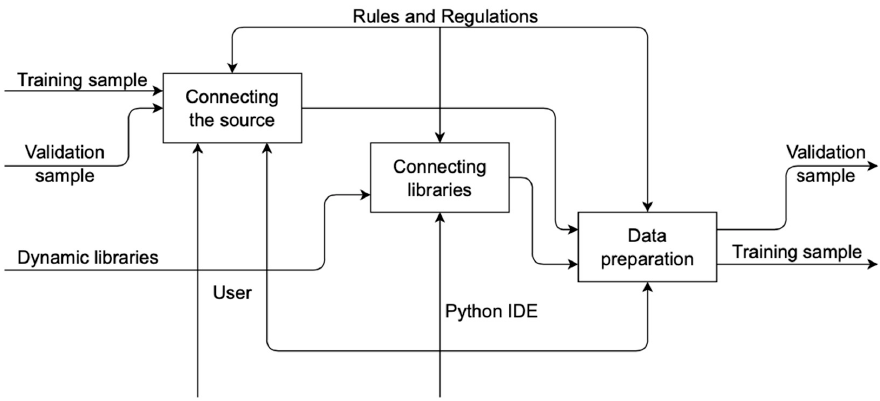
Figure 3. Decomposition of the “Data Preparation” process.